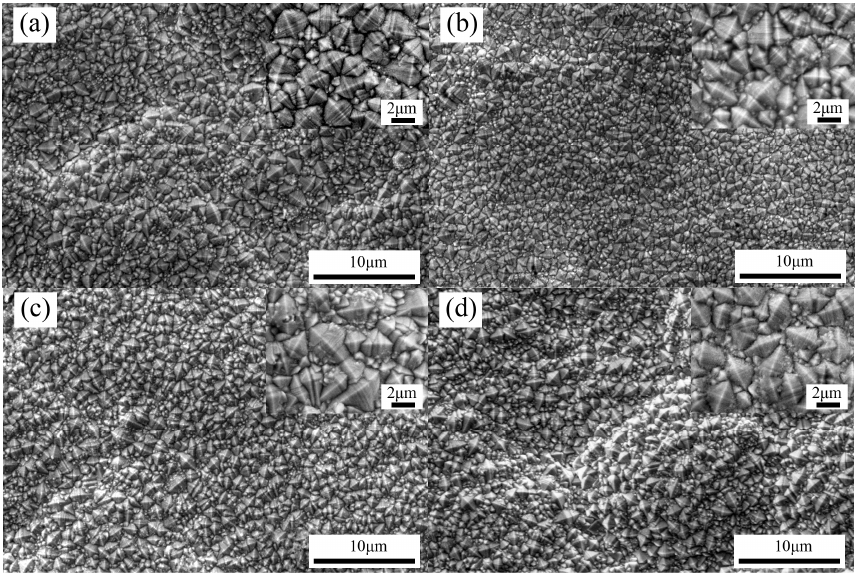
Figure 3. Surface morphologies of the Ni–Co–BN (h) nanocomposite coatings with duty cycle of 0.7 and varying pulse frequencies: ( a ) 2 kHz, ( b ) 6 kHz, ( c ) 8 kHz, ( d ) 10 kHz.